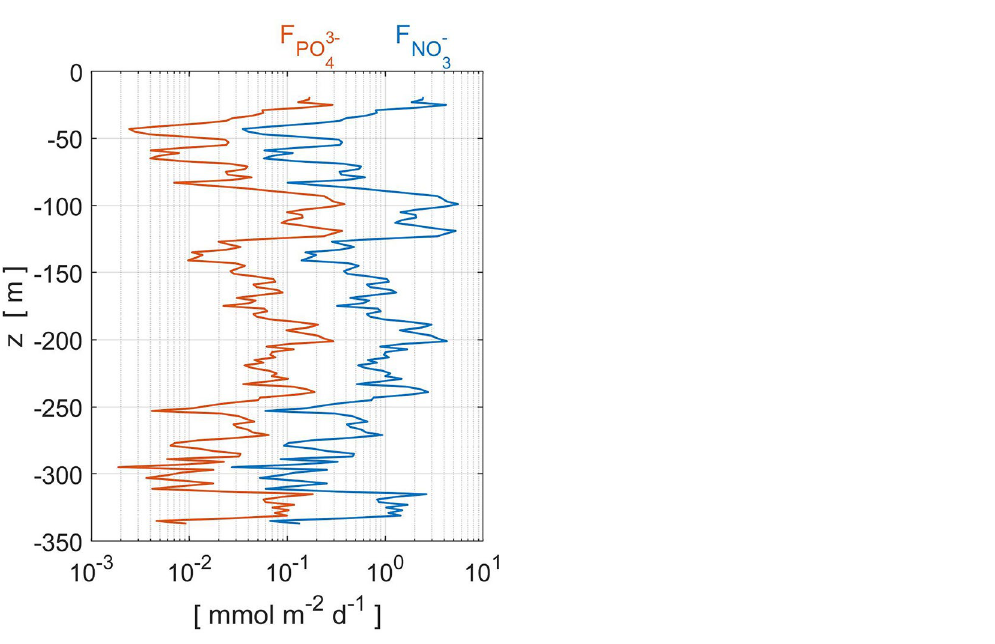
Figure 7. Vertical profiles of vertical turbulent flux of nitrate (blue) and phosphate (red) estimated at station